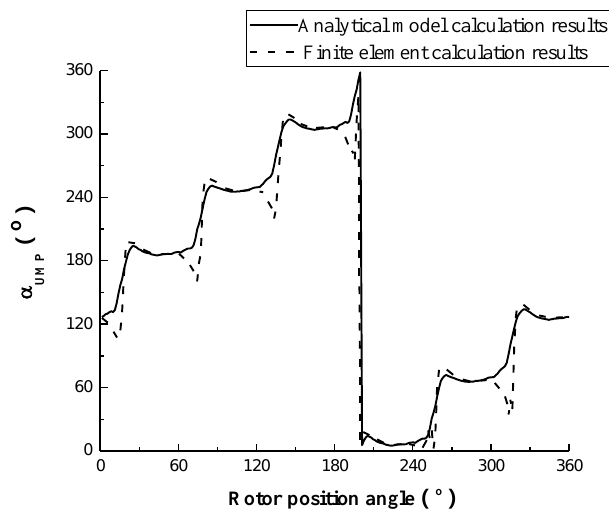
Figure 12. The Y -axis UMP of rotor in fault.